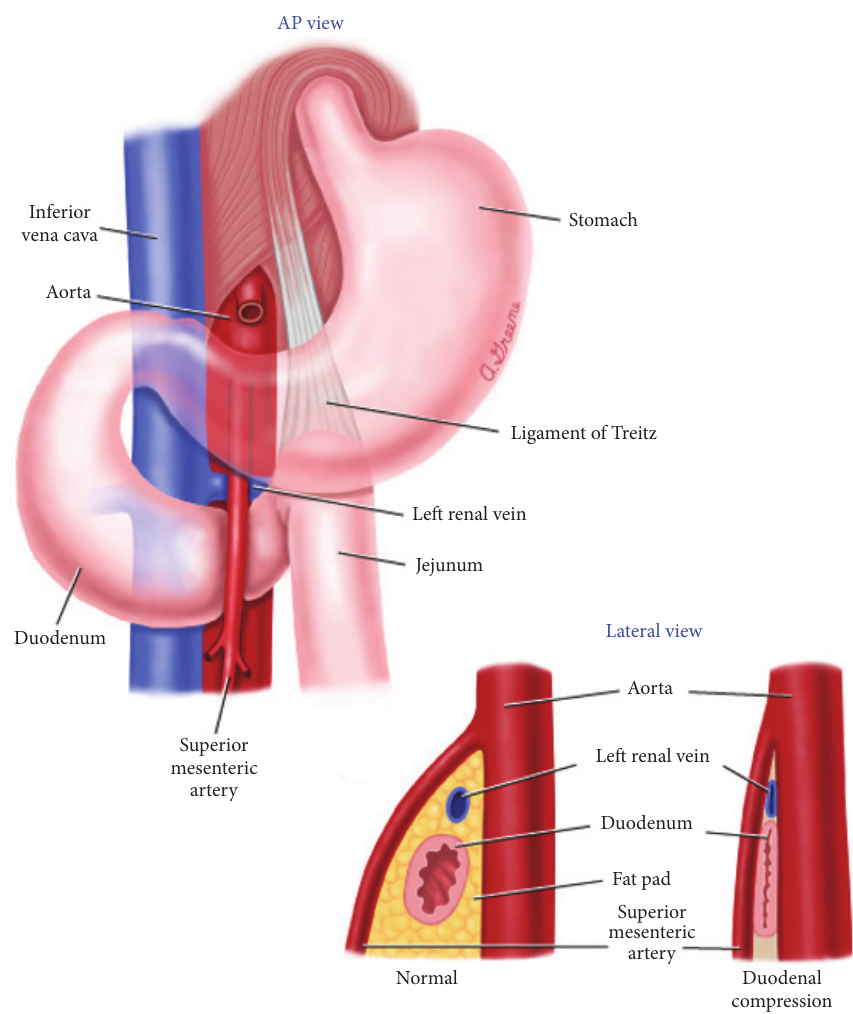
Figure 5: Superior mesenteric artery (SMA) syndrome. The superior mesenteric artery arises from the anterior aspect of the aorta at the level of the L1 vertebral body. It is enveloped in fatty and lymphatic tissue and extends in a caudal direction at an acute angle into the mesentery. In the majority of patients, the normal angle between the superior mesenteric artery and the aorta is between 38 and 65 degrees. Superior mesenteric artery syndrome is characterized by compression of the third portion of the duodenum due to narrowing of the space between the superior mesenteric artery and aorta and is primarily attributed to loss of the intervening mesenteric fat pad. With superior mesenteric artery syndrome, the angle between the superior mesenteric artery and the aorta can be narrowed to as little as 6 degrees (Case Report One) (see